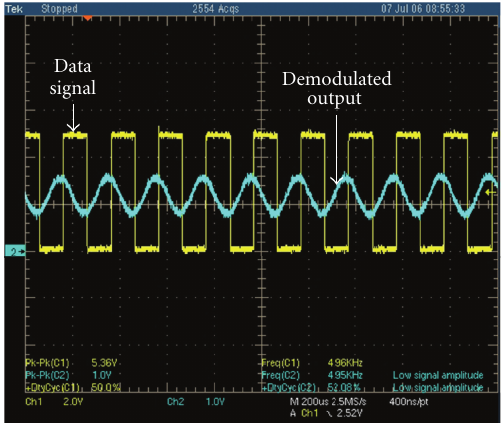
Figure 13: Demodulator output (blue) with 10kbps data signal